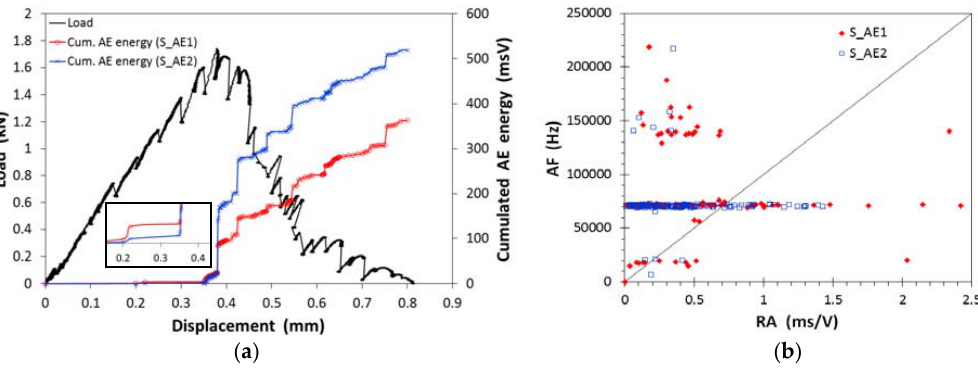
Figure 6. Test 1: ( a ) load and cumulated AE energy vs. displacement diagrams; ( b ) RA values of detected Acoustic Emission (AE) events (S AE1 = wideband sensor, S AE2 = resonant sensor).